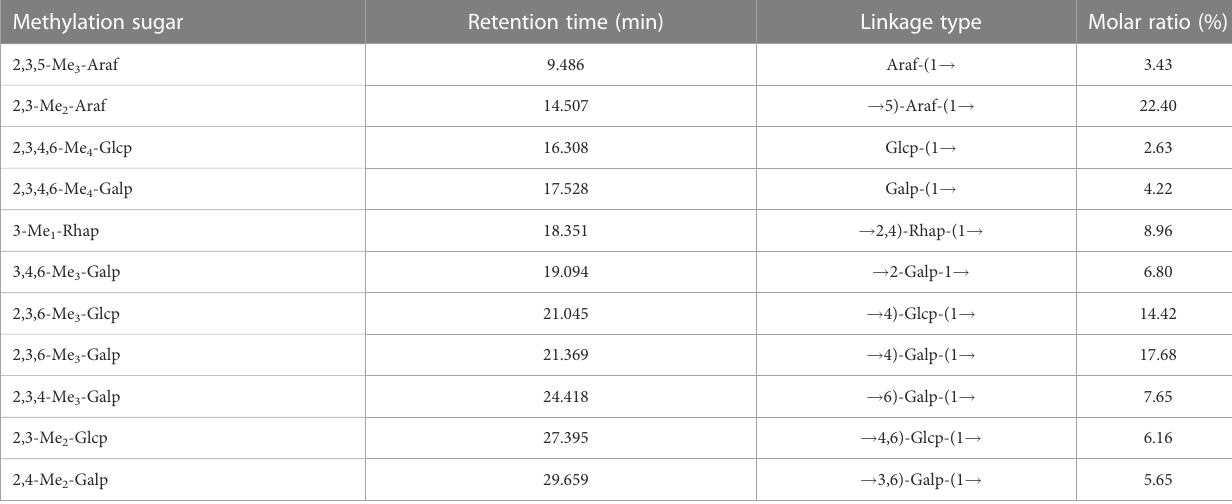
TABLE 3 Linkage analyses of YZ0.5-A and its degraded products.